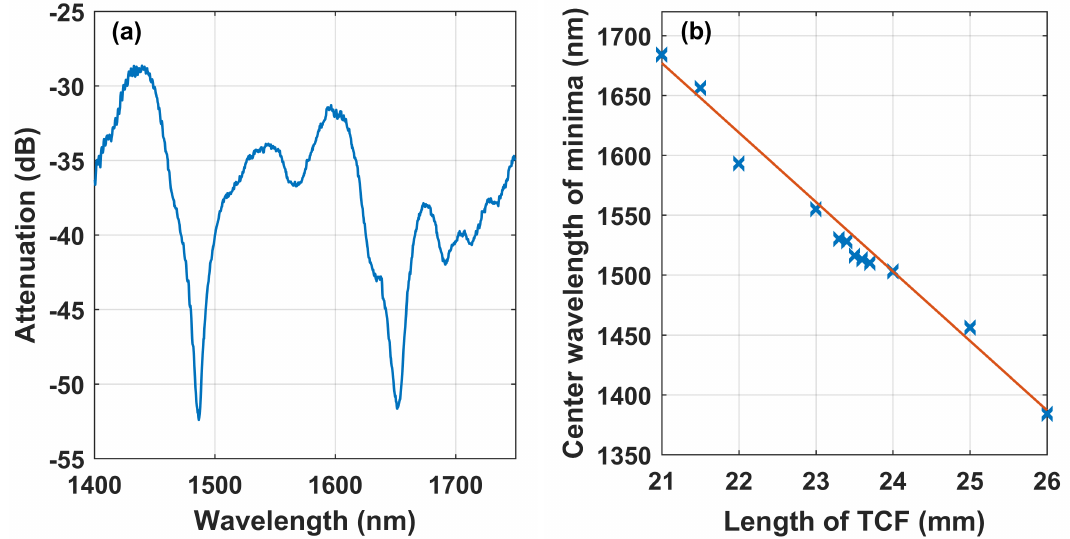
Figure 5. Typical transmission spectrum measured on a TCF inline sensor with a length of 24.2 mm held in air ( a ) and center wavelength for the left minima in ( a ) as a function of TCF length ( b ) .